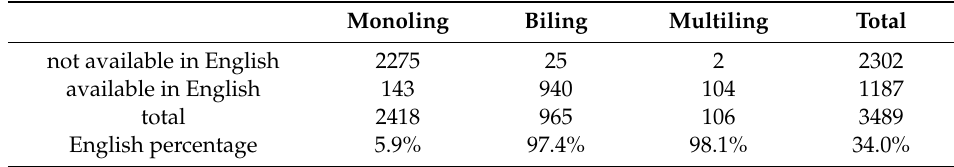
Table A8. English language availability (hr).